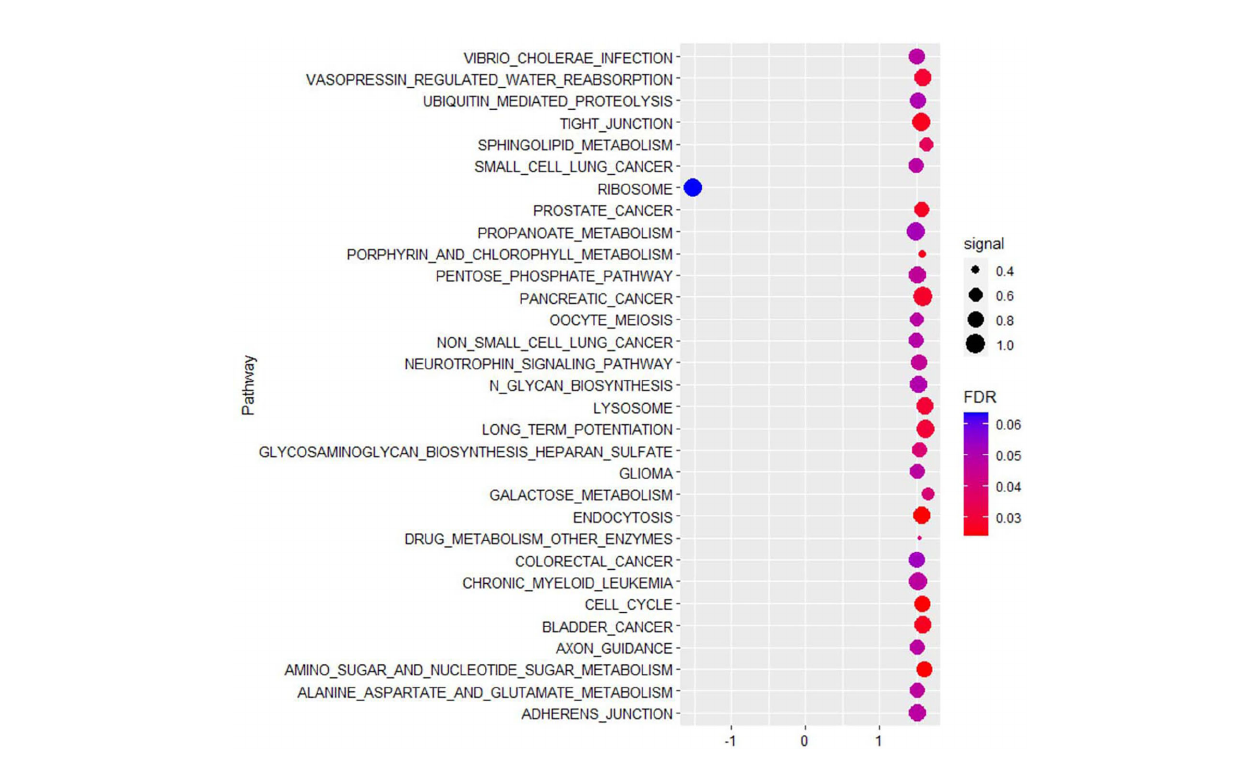
FIGURE 2 | The top 30 KEGG pathways enriched by gene set enrichment analysis (GSEA) showed that differentially expressed genes of parathyroid adenoma were enriched in multiple biological processes, such as ribosome, lysosome, cell cycle and tight junction. The horizontal axis represents the normalized enrichment score (NES), and the vertical axis represents the KEGG pathways. The false discovery rate (FDR) value and enrichment signal are represented by the color and circle diameter,